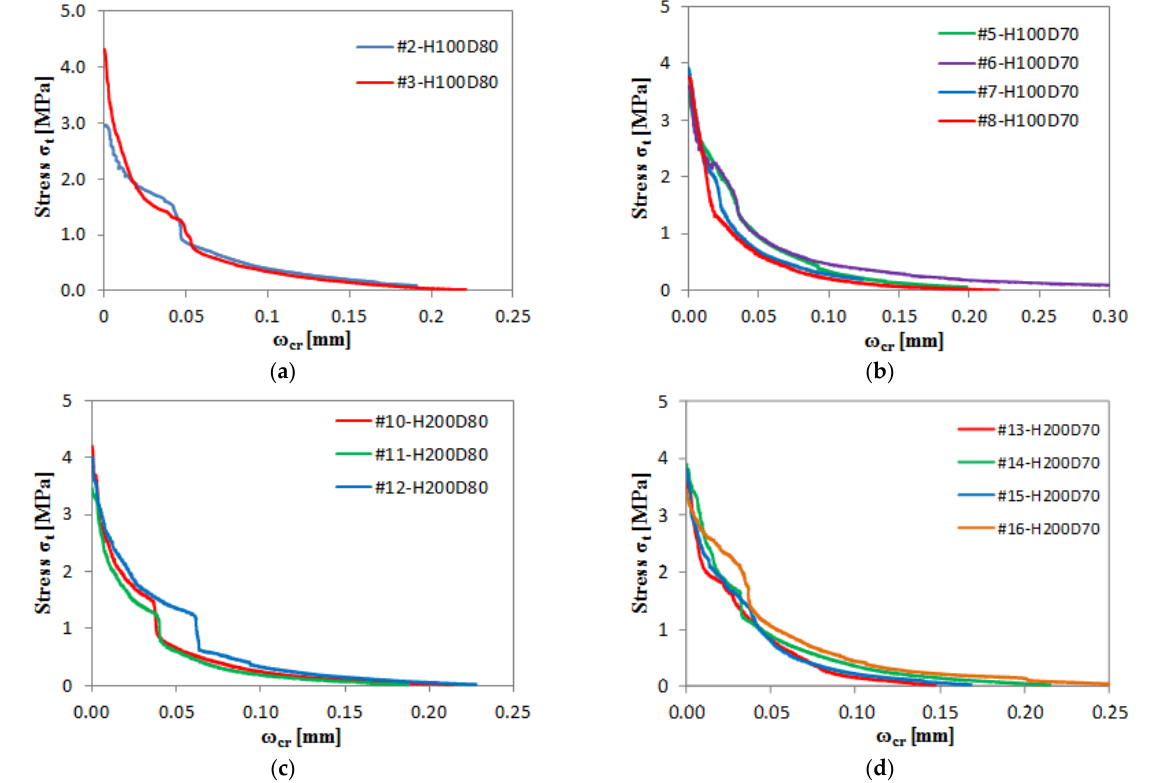
Figure 4. The tested stress–crack-width curves for; ( a ) Sample H100D80, ( b ) Sample H100D70, ( c ) Sample H200D80 and ( d ) Sample H200D70.